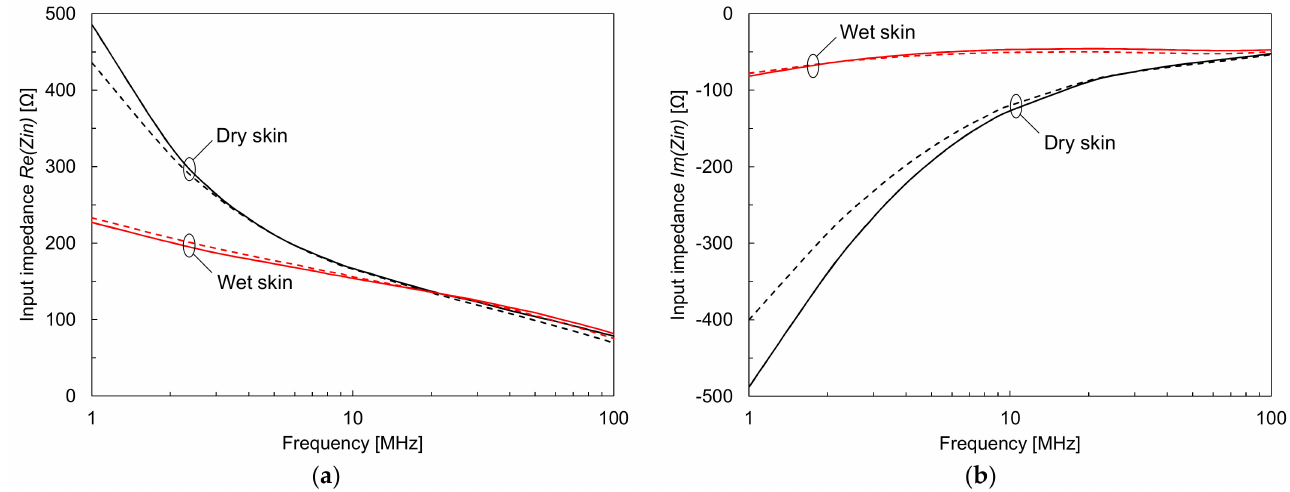
Figure 4. Input impedance characteristics of a wearable antenna calculated for a realistic human body model: ( a ) Real component of input impedance characteristics; ( b ) imaginary component of input impedance